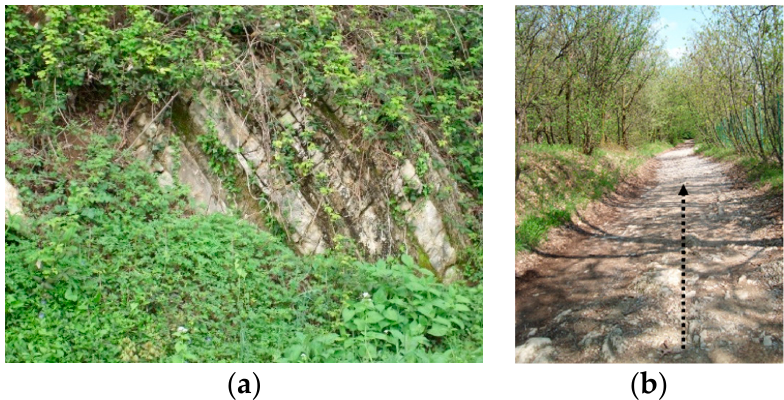
Figure 1. Overview of the acquisition site: ( a ) Example of geological evidence; and ( b ) photograph of the survey site. The black arrow represents the survey line.